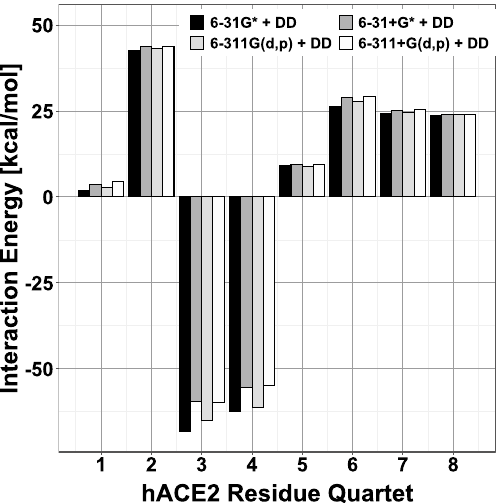
Figure 3. Partial energies of hACE2 interaction with the S-RBD. Main repulsive (positive) and attractive (negative) interaction energies [kcal/mol] between hACE2 quartets , used as structural references, and neighboring SARS-CoV-1 S-RBD residues. The four adjacent vertical bars for each quartet correspond, from left to right, to dispersion -corrected [DD] 27 evaluations with the 6-31G*, 6-31+G*, 6-311G(d,p) and 6-311+G(d,p) basis